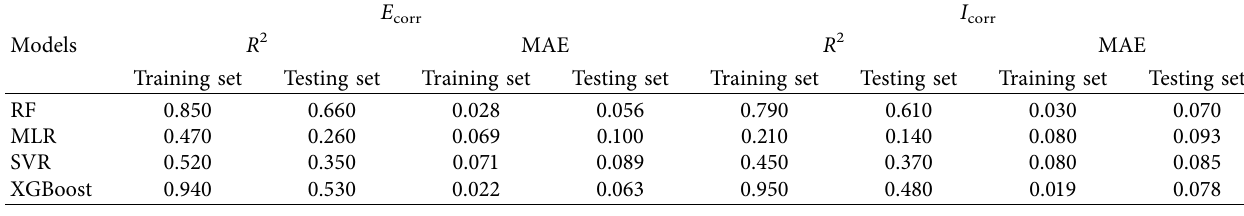
Table 5: Prediction accuracy of each algorithm (the R 2 and MAE calculation results for each optimized model in the training set and testing set).